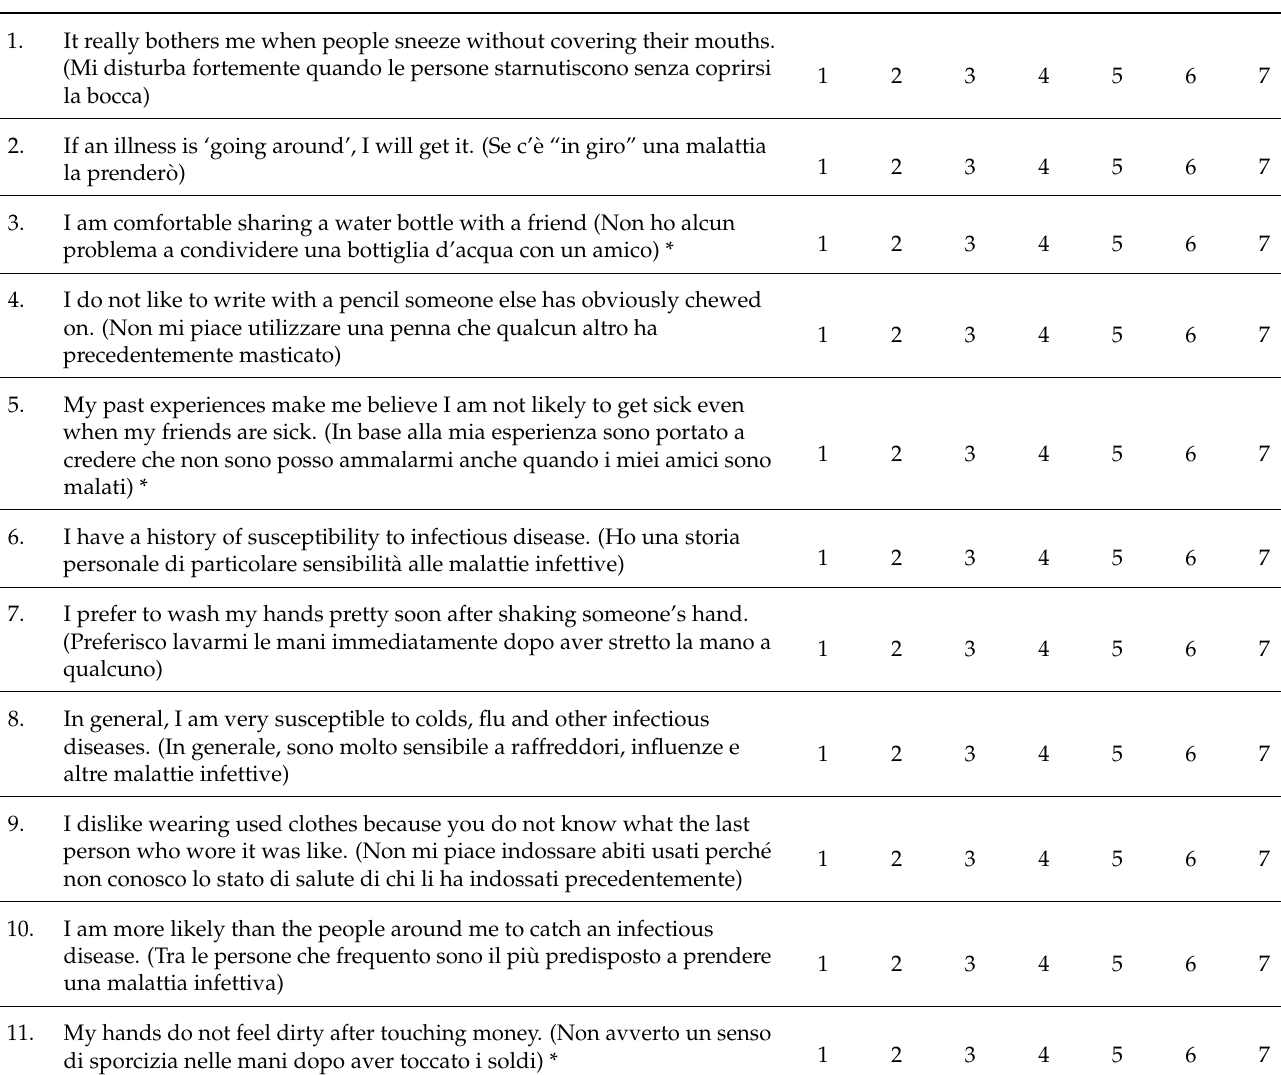
Table A2. Perceived Vulnerability to Disease (PVD, Duncan et al., 2009); in brackets: Italian